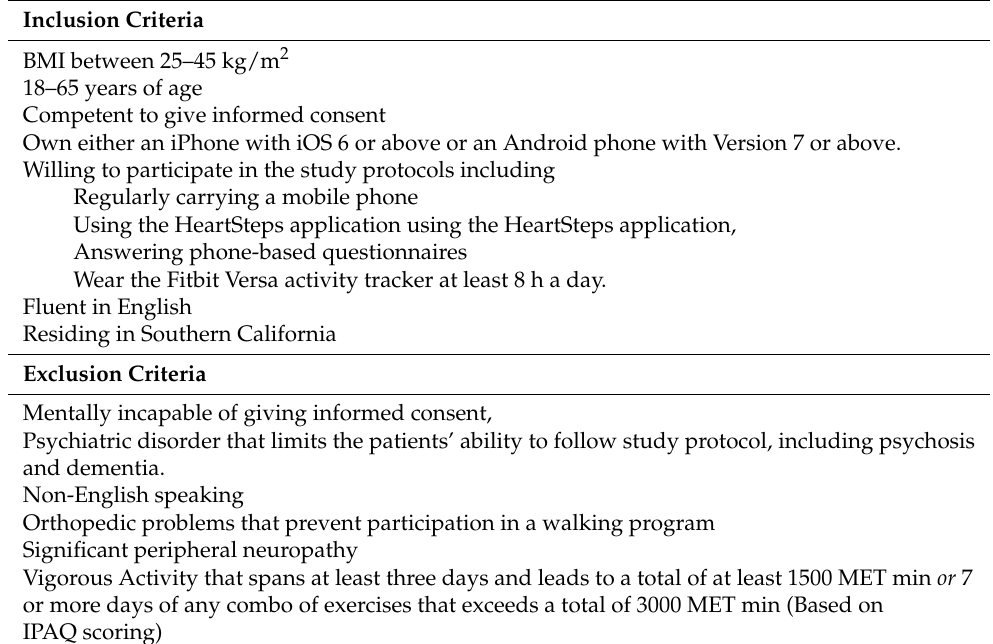
Table 3. HeartSteps Inclusion and Exclusion